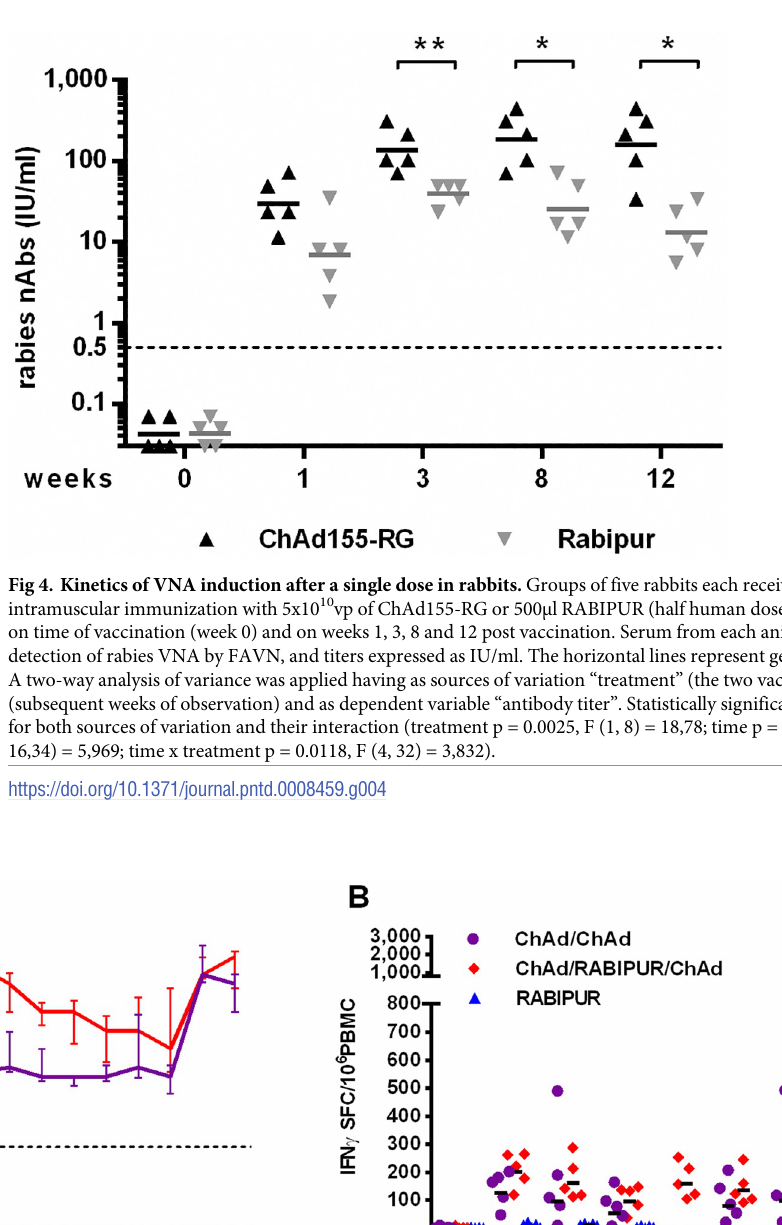
PLOS NeglectedTropical Diseases | https://doi.org/10.1371/journal.pntd.0008459 July 15,